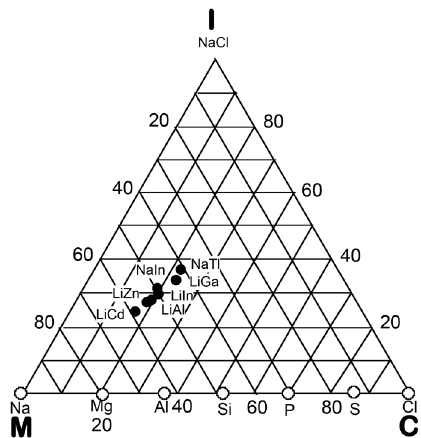
Figure 57. Van Arkel-Ketelaar triangle map for Zintl compounds. It was constructed by inserting Allen’s electronegativity data (Table 2) into Equations (17) and (18) [11].